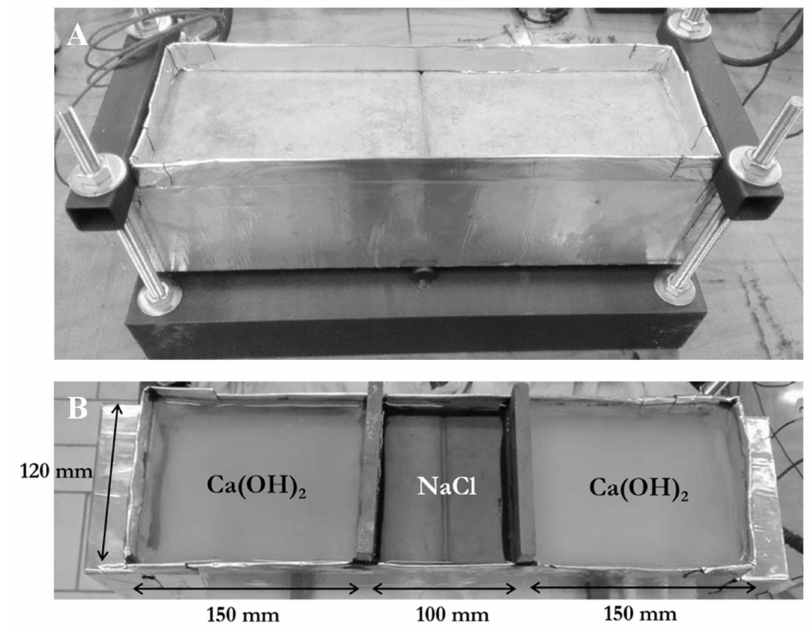
Figure 2. Concrete beam mounted in the three-point bending test frame ( A ), reservoirs on (uncracked) beam for the weekly exposure to NaCl exposure in the middle compartment and Ca(OH) 2 solution in the outer compartments ( B